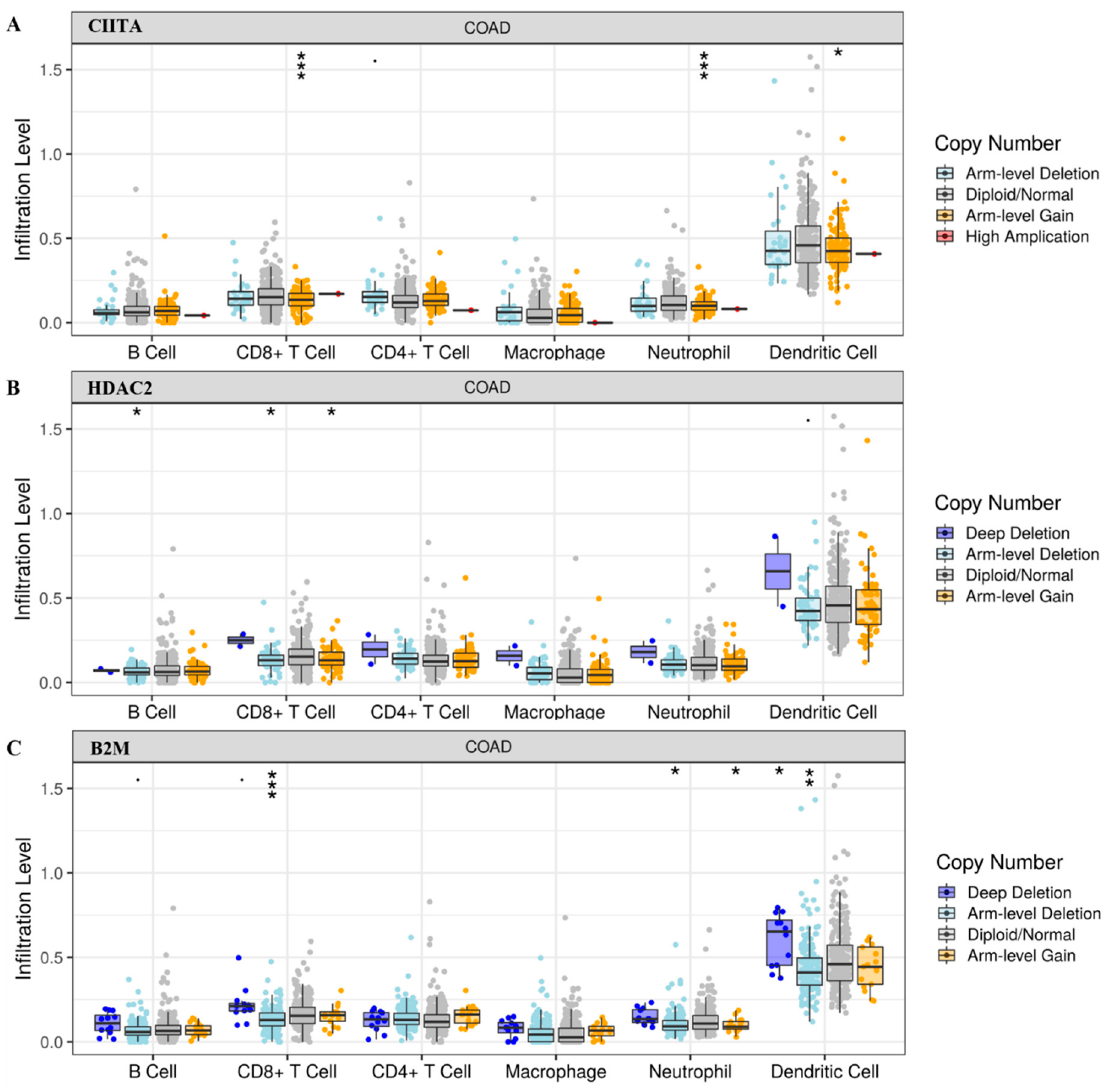
Figure 1. Tumor infiltration levels in ( A ) CIITA , ( B ) HDAC2 , and ( C ) B2M in COAD tumors with SCNAs in the indicated genes. Significant p -values: *** ≤ 0; ** ≤ 0.001; * ≤ 0.01.